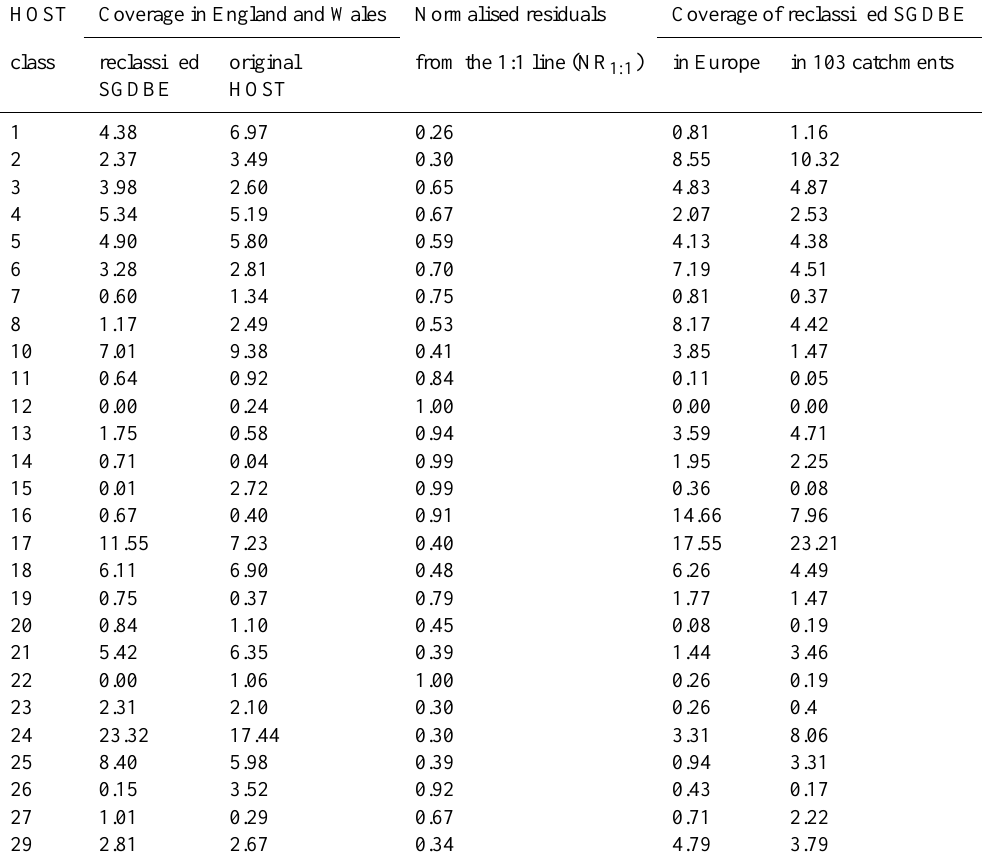
Table 2. Percentage coverage of HOST classes in England and Wales in the reclassified Soil Geographical Database of Europe (SGDBE) as compared to the original HOST map with associated normalised residuals and percentage coverage of HOST classes in the reclassified SGDBE in Europe and in the 103